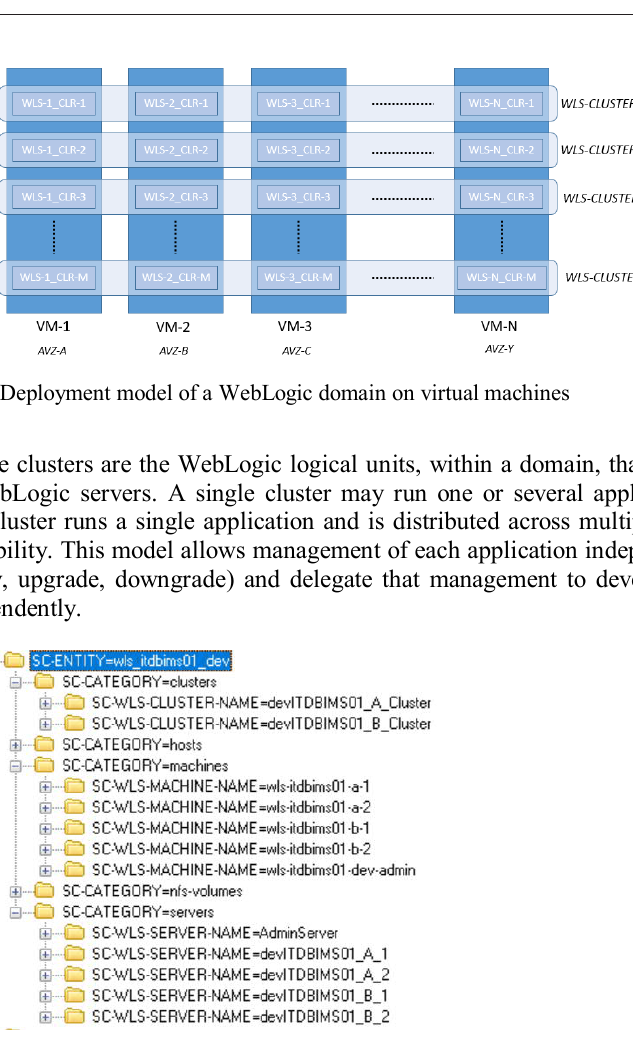
Fig. 2. Example of representation of WebLogic domain in an LDAP